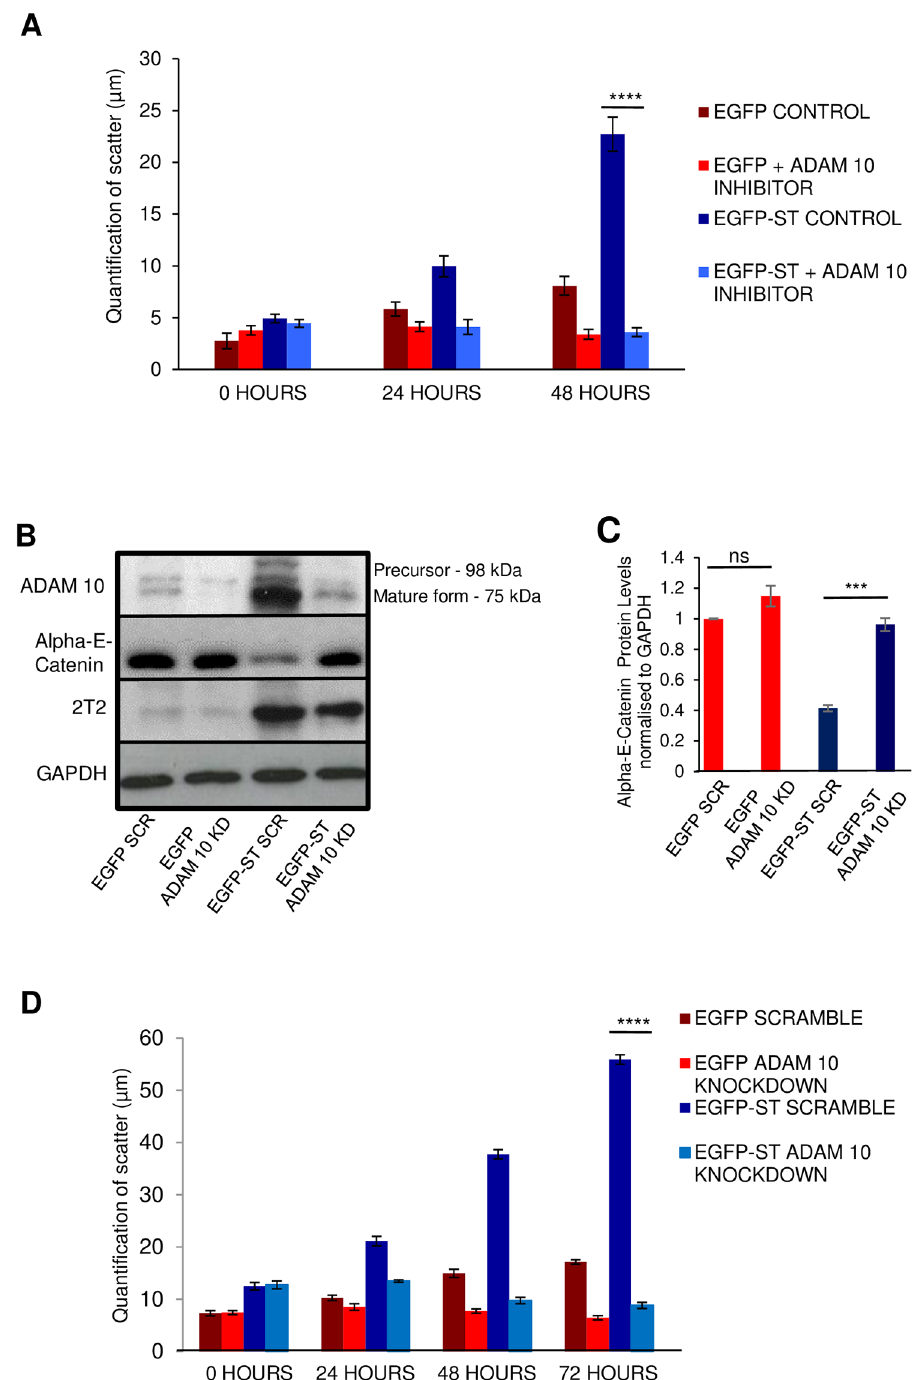
Fig 6. ADAM 10 is required for MCPyV ST-induced cell dissociation. (A) EGFP or EGFP-ST transfected HEK 293 cells were incubated with the ADAM 10 specific inhibitor, GI254023X (50 μM), then serum starved for 24 hours to induce aggregate formation. Upon reintroduction of serum, cells were fixed and stained with DAPI at 24 hourly intervals. Images were analysed using Image-J to quantify the distance between each cell nucleus. Data analysed using three replicates per experiment, n = 50 cells, by a two-tailed t-test with unequal variance, (cid:3)(cid:3)(cid:3)(cid:3) = p (cid:20) 0.0001. (B) HEK 293 cells were transfected with 1 μg EGFP or EGFP-ST in the presence of either scramble or ADAM 10-specific siRNAs. After 24 hours, cell lysates were probed using ADAM 10- and Alpha-E-catenin specific antibodies. GAPDH was used to measure equal loading. 2T2 was used to probe for MCPyV ST expression. (C) Densitometry